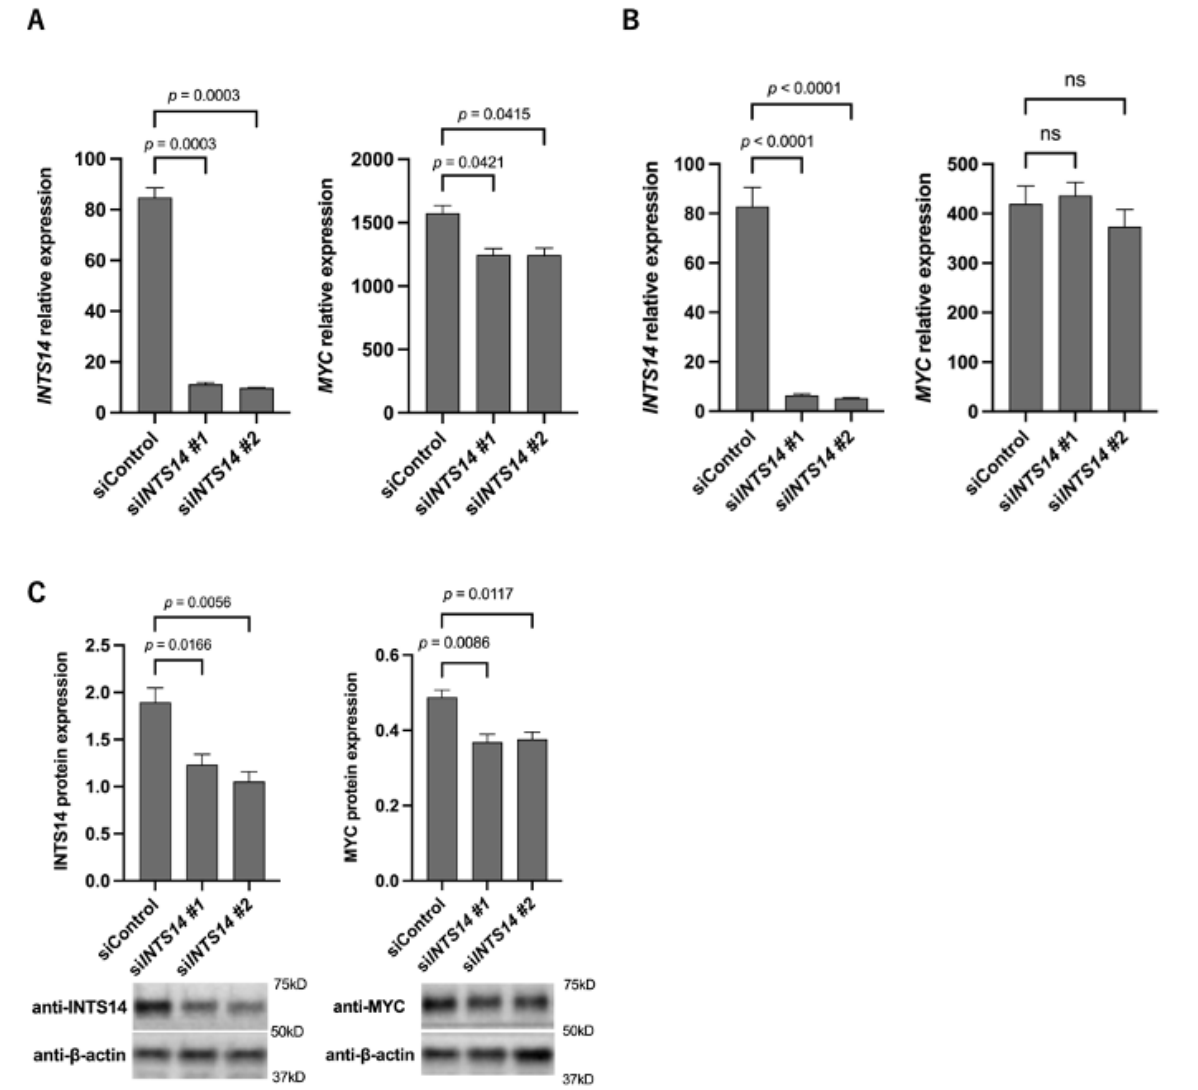
Figure 4. Knockdown of INTS14 reduces MYC mRNA and protein expression in prostatic cell lines (PC-3). ( A ) qPCR of INTS14 knockdown by siRNA transfection in PC-3 cells. ( B ) qPCR of INTS14 knockdown by siRNA transfection in HuH-7 cells. ( C ) Western blotting analysis of INTS14 knockdown by siRNA transfection in PC-3 cells. The values shown are the means ± SEM (n = 3). Not significant (ns).